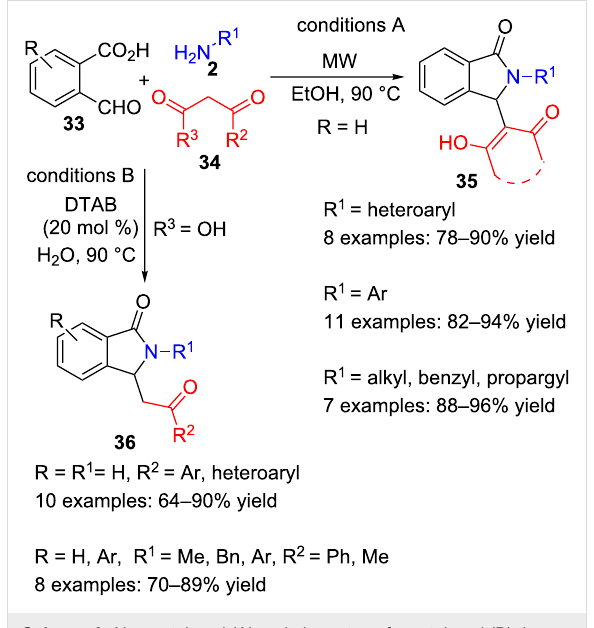
Scheme 9: Non-catalysed (A) and phase-transfer catalysed (B) three- component reactions of formylbenzoic acids 33 , amines 2 and 1,3- dicarbonyl derivatives 34